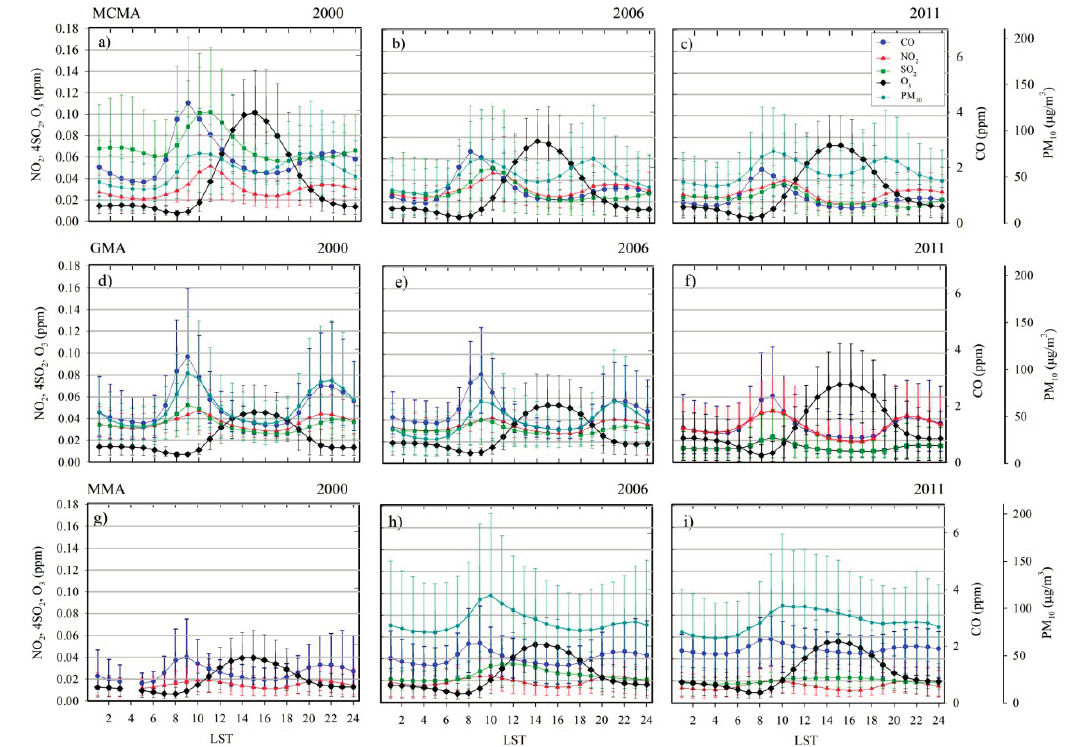
Figure 7. Diurnal behavior of CO, NO and MMA ( g – i ) during 2000, 2006, and 2011. The bars indicate the range from the 10th to the 90th